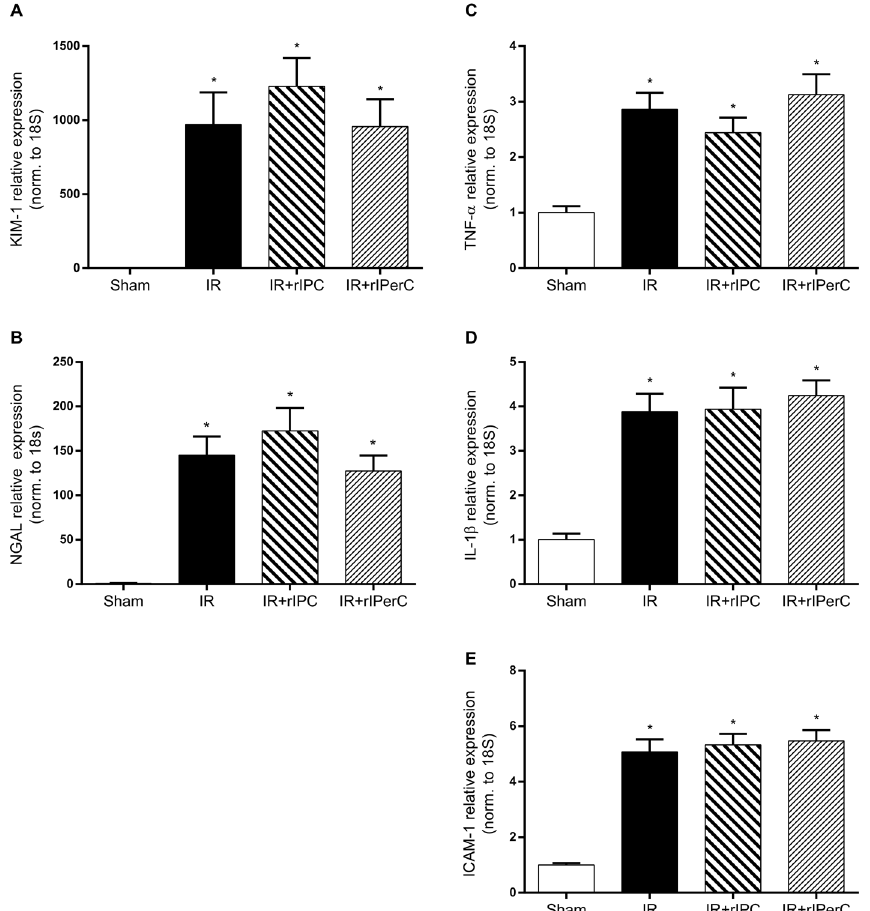
Fig 3. Effect of ischemia-reperfusion injury and remote ischemic conditioning on the renal expression of injury and inflammatory markers after 7 days of reperfusion. A) Kidney injury molecule-1 (KIM-1). B) Neutrophil gelatinase-associated lipocalin (NGAL). C) Tumour necrosis factor- α (TNF- α ). D) Interleukin-1 β (IL-1 β ). E) Intercellular adhesion molecule-1 (ICAM-1). Bars represent mRNA levels by quantitative polymerase chain reaction in the left renal cortex/outer medulla normalised to 18S mRNA. All values are expressed as mean ± SEM. Group means were compared using one-way analysis of variance followed by Bonferroni ’ s multiple comparison post-test. * P < 0.05 vs. sham. Number of animals (all markers): sham (n = 7), ischemia-reperfusion (IR; n = 10), IR and remote ischemic preconditioning (IR+rIPC; n = 10), IR and remote ischemic perconditioning (IR+rIPerC; n =